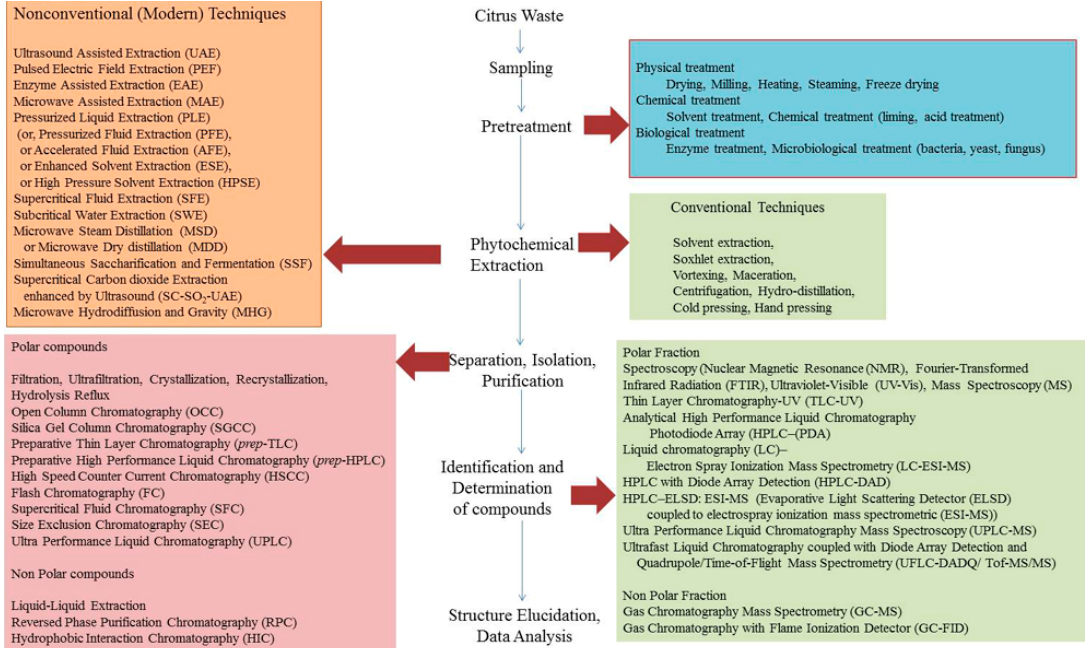
Figure 5. The steps involved in the extraction, separation, isolation, and purification of important compounds from citrus waste and techniques employed for determination and structural elucidation.